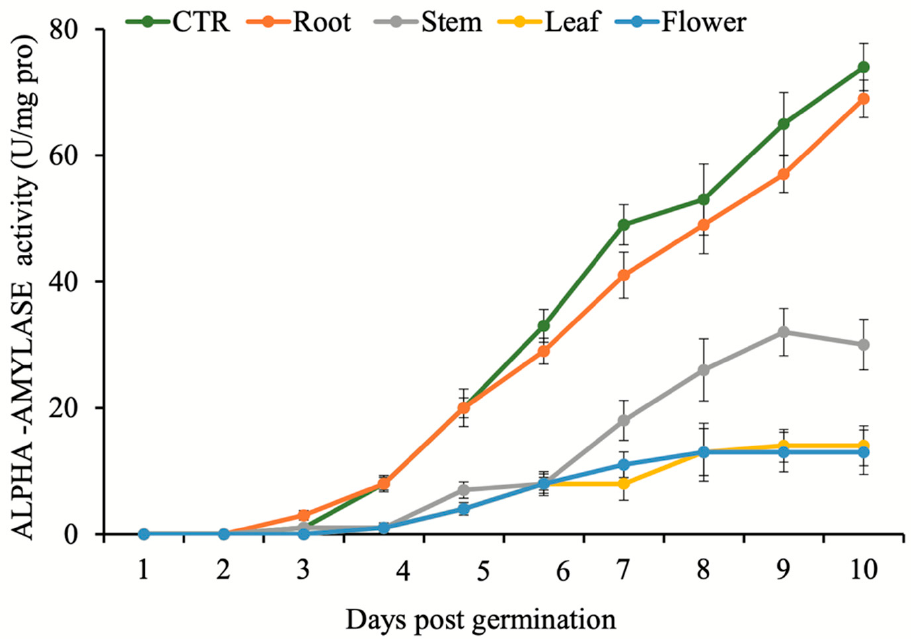
Figure 1. Effect of N. meyeri extracts on alpha ‐ amylase activity in germinating C. campestris (dodder) seeds. Dodder seeds were treated either by distilled water (CTR) or extracts from different N. meyeri plant parts. Error bars represent standard errors calculated from three biological replicates .